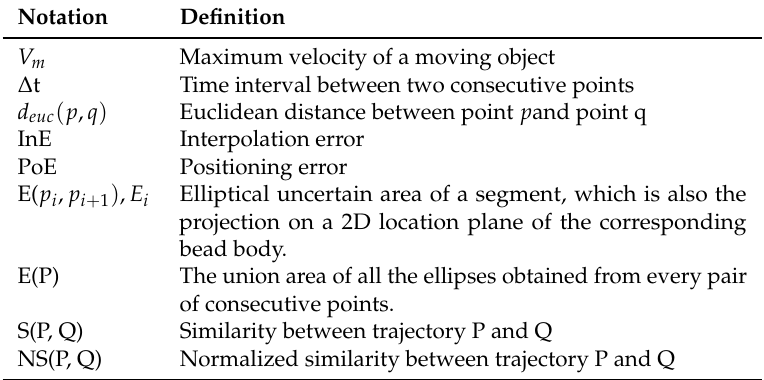
Table 1. Notations and